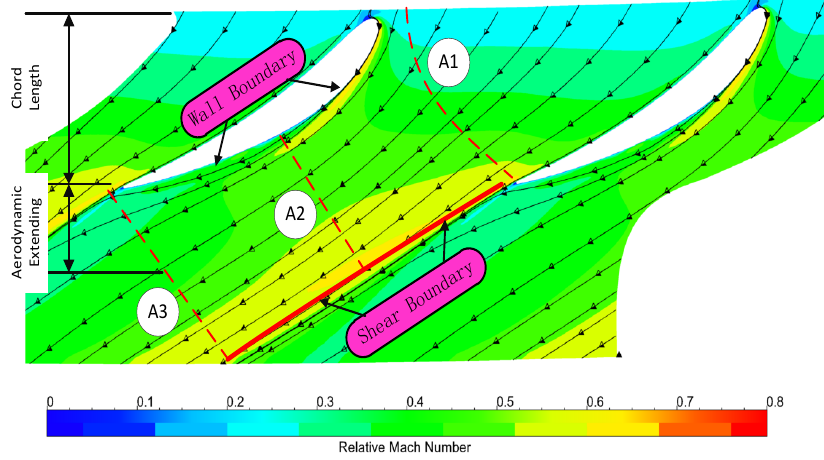
Figure 11. Relative Mach number distributions of the rotor of the designed high-reaction tip turbine.